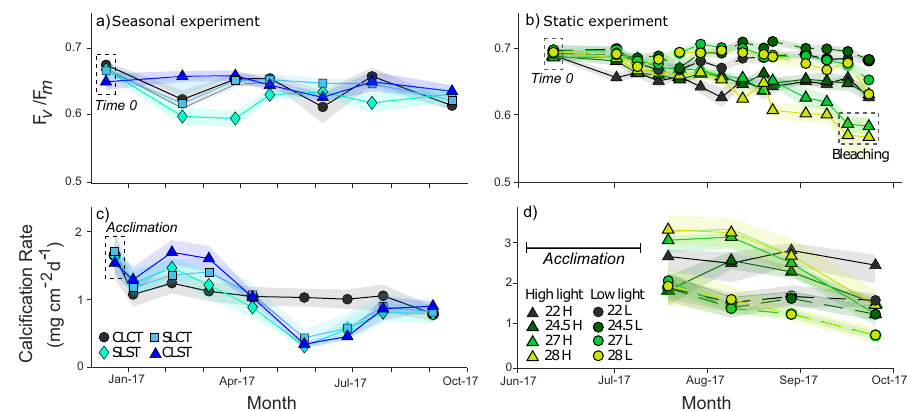
Fig. 1 Timeseries of coral photo-physiology and calci fi cation rates. Changes in F v /F m (mean ± 1 SE) during ( a ) the seasonal experiment and ( b ) static experiment. Temporal changes in calci fi cation rates during ( c ) the seasonal experiment and ( d ) static experiment. Treatment conditions in the seasonal experiment are as follows: constant light and constant temperature (CLCT), seasonal light and constant temperature (SLCT), constant light and seasonal temperature (CLST), and seasonal light and seasonal temperature; (SLST). Treatment conditions for the static experiment are high and low light levels fully crossed with four temperatures. Note different date range on x-axis for each panel.